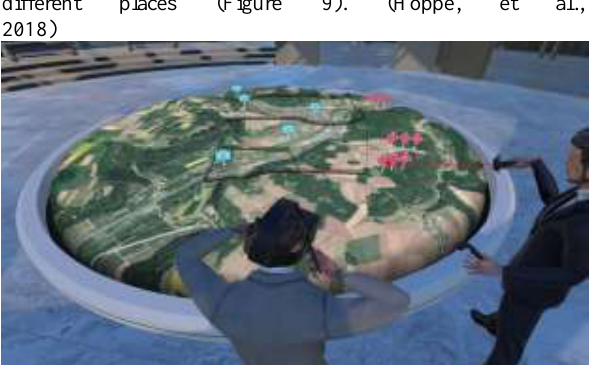
Figure 9: Meeting within the VR environment